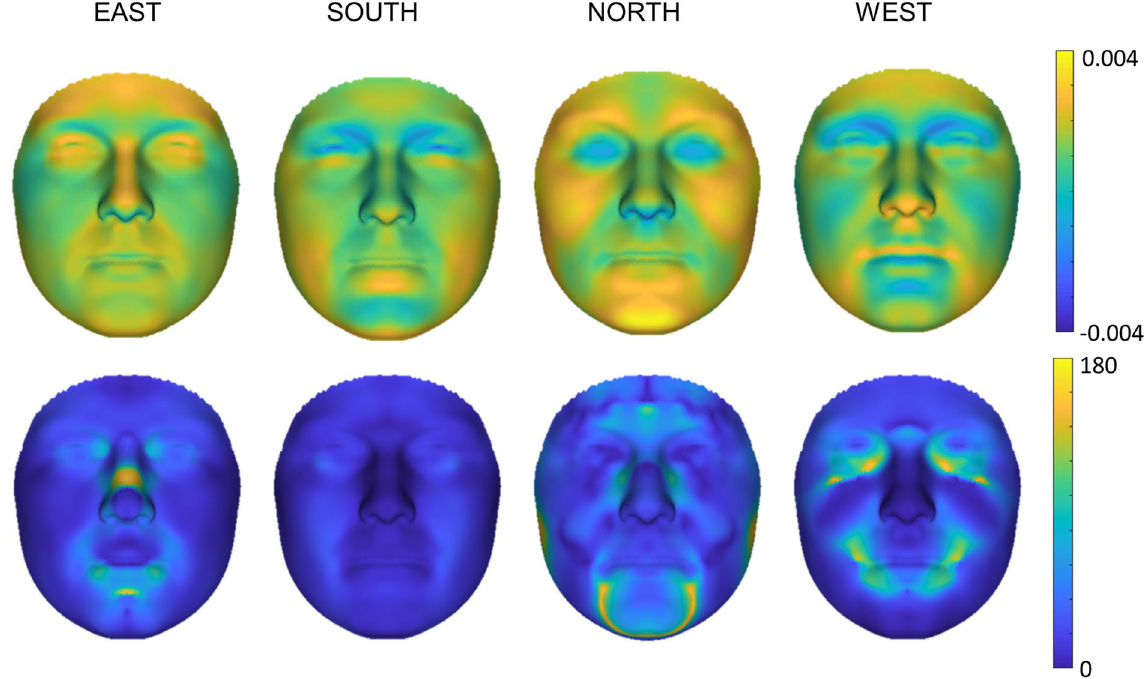
Figure 6. Consensus and genetic PC face comparisons. Normal displacement (top row—magnitude of inward/ outward movement where yellow shows higher magnitude in consensus faces and blue in PC faces) and angle differences (bottom row—directional differences in shape change in degrees) between consensus faces and average genetic PC faces per region (n = 186 per